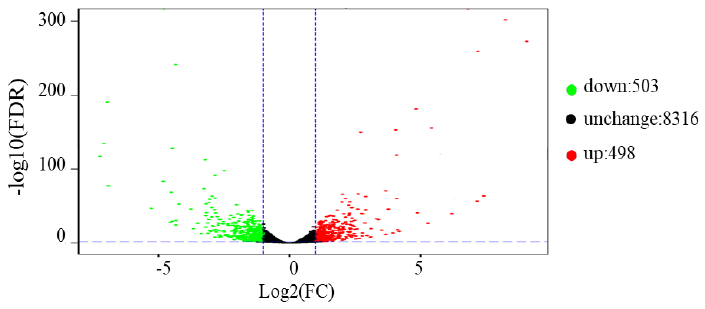
Figure 6. Differential expression analysis between blnR OE and the wild-type strain. Table 2. List of genes up- or down regulated in blnR OE as compared with the wild-type strain based on RNA-seq analysis.